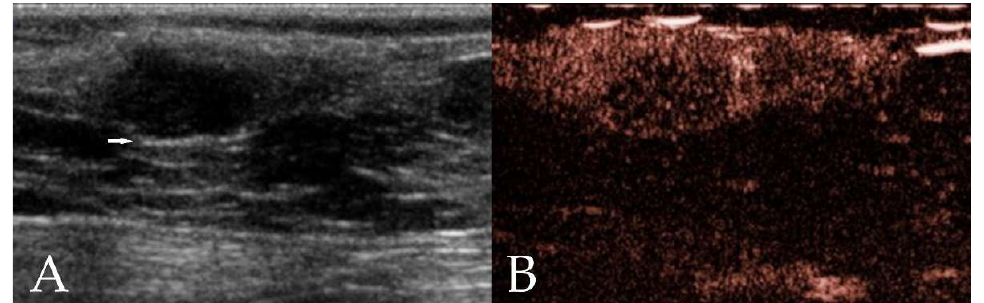
Figure 1. Ultrasonographic images of a mammary adenoma in a 12 year old intact Border Collie. ( A ) On B-mode ultrasonography, the neoplasm shows an ovoid shape, well-defined border, hypoechoic homogeneous echotexture, and the presence of edge enhancement (arrow). ( B ) Contrast-enhanced ultrasonography (CEUS) shows heterogeneous enhancement.